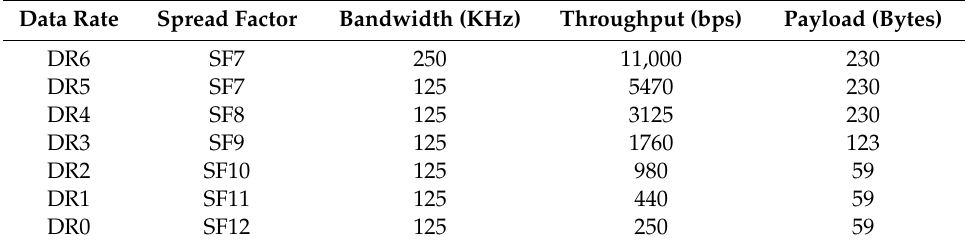
Table 5. LoRa parameters in EU868, EU433, CN470, and AS923 bands, frequency of 868 MHz [56].